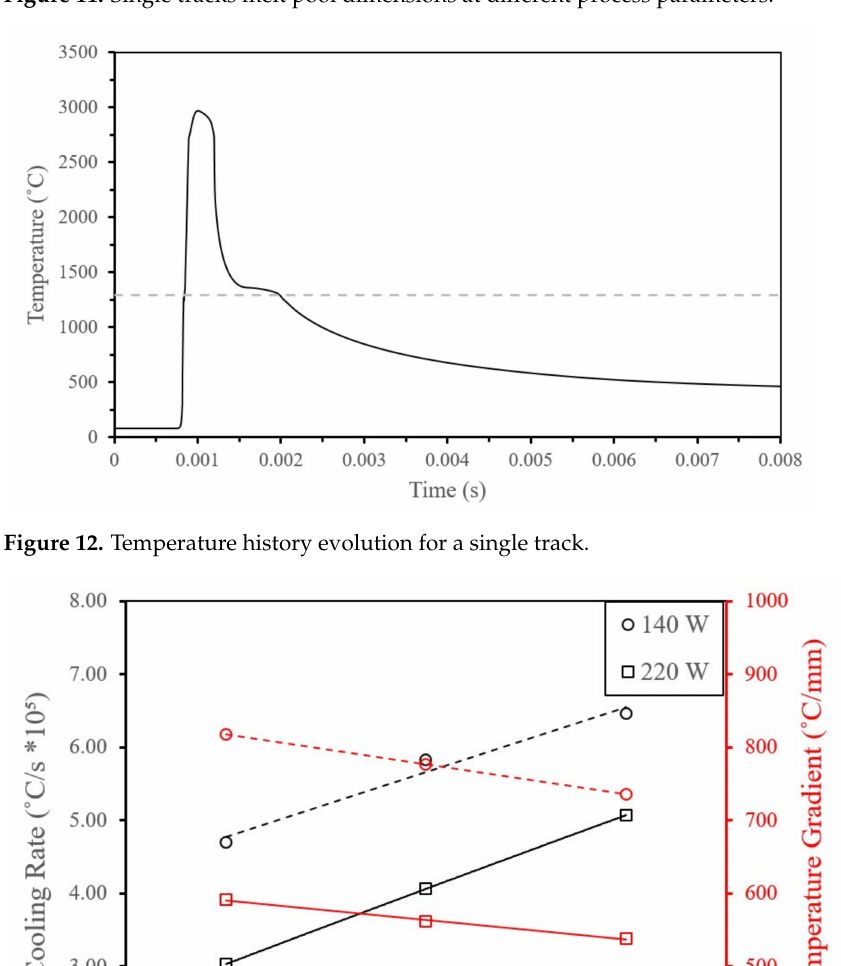
Figure 11. Single tracks melt pool dimensions at different process parameters.